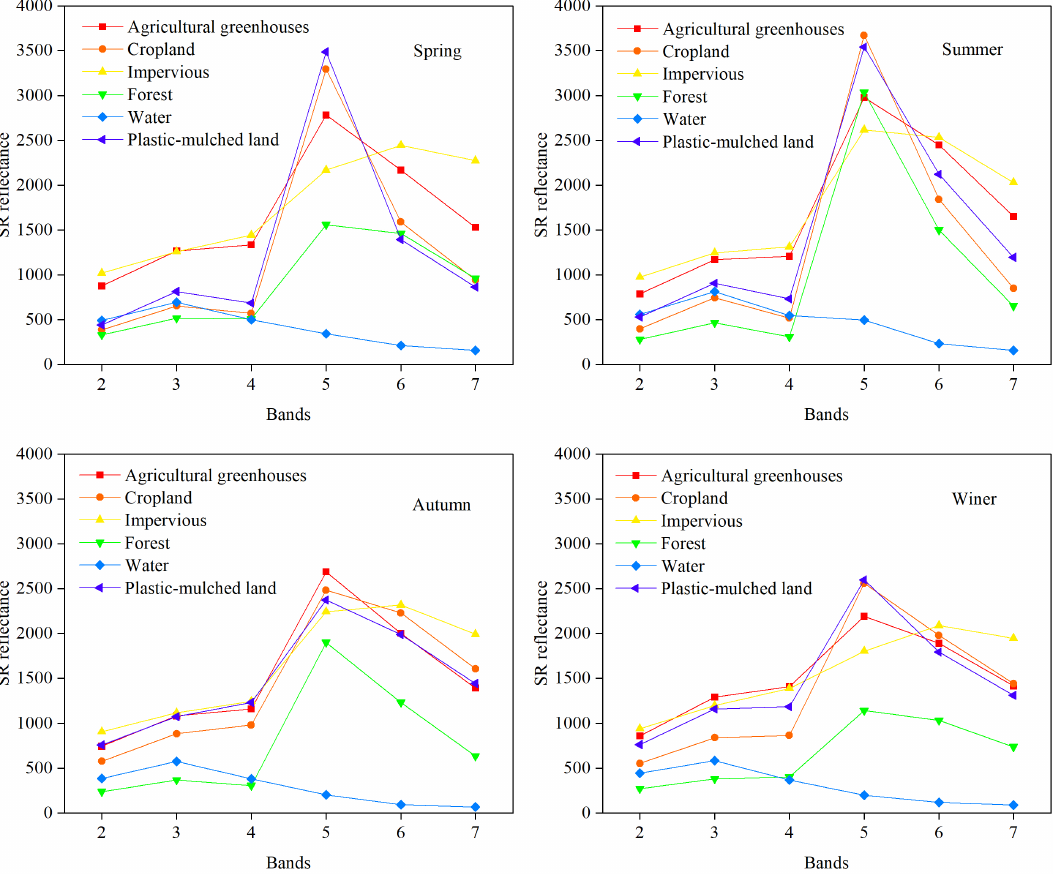
Figure 5. Spectral curves of different land cover types (SR reflectance in median value) in different